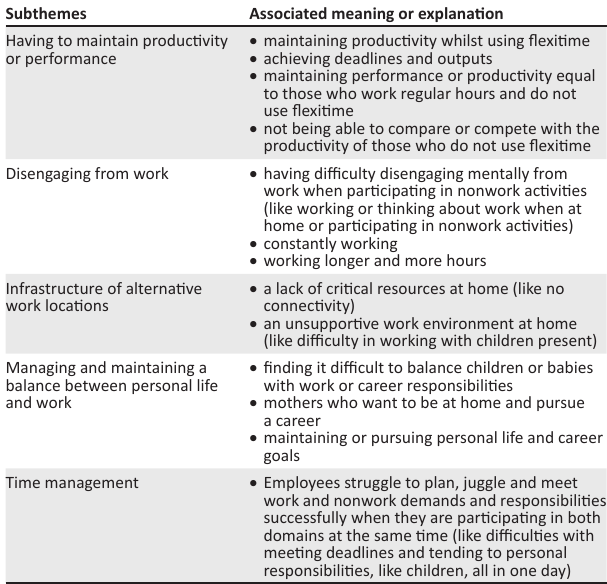
TABLE 1: Individual challenges associated with using flexitime.